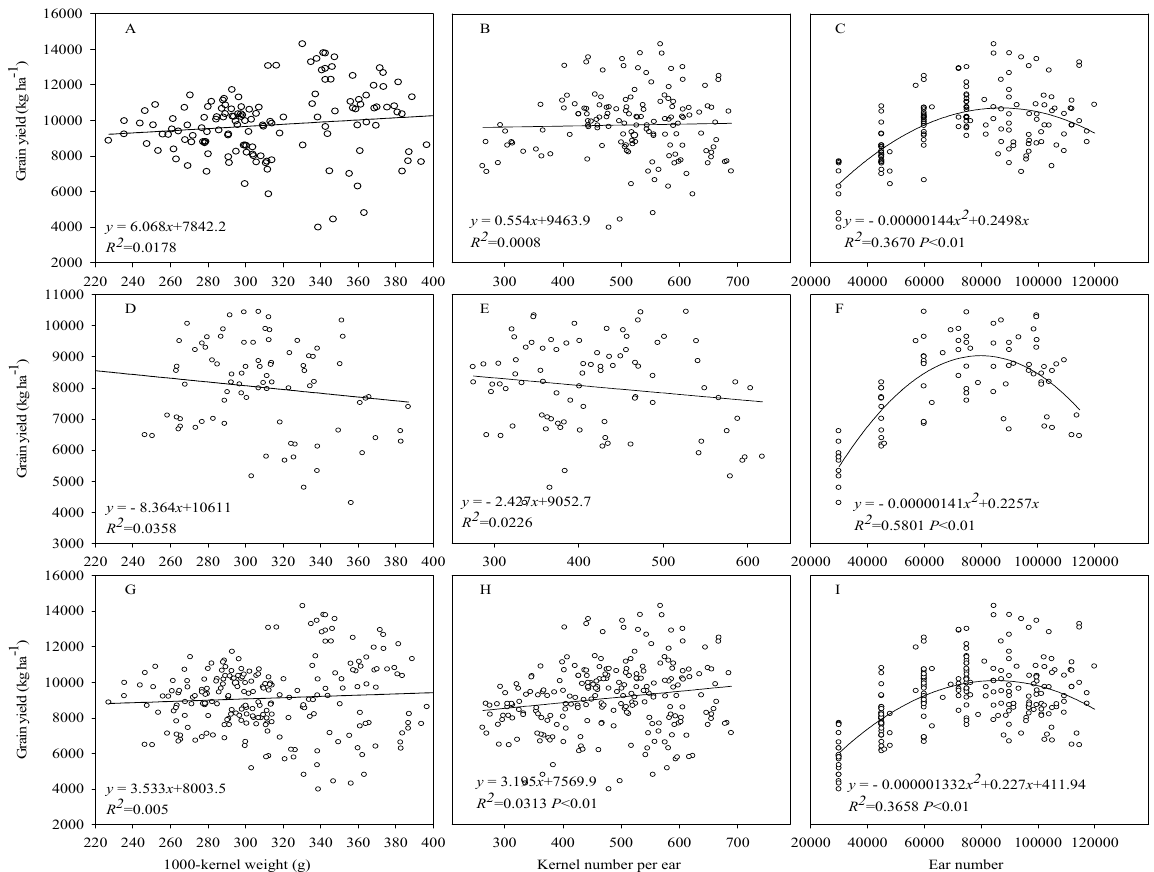
300 252 Figure 2. Relationship between grain yield and its components. 253 Figure 2. Relationship between grain yield and its components. Note: Figure ( A – C ) represent the relationship between grain yield and yield components in Taihe. Figure ( D – F ) represent the rela- tionship between grain yield and yield components in Hefei. Figure ( G – I ) represent the relationship Note: Figure A, B and C represent relationship between grain yield and yield components in Taihe. Fig- 254 between grain yield and yield components in Taihe and Hefei. ure D, E and F represent relationship between grain yield and yield components in Hefei. Figure G, H 255 and I represent relationship between grain yield and yield components in Taihe and Hefei. 256 The quadratic model observed that, between grain yield and planting density (Table 5), with the significant regression equation y = − 1.44 × 10 − 6 x 2 + 0.2498 x ( R 2 = 0.367) in Taihe, the agronomic optimal planting density (AOPD) was 8.6 × 10 4 plants ha − 1 based on the equation, and yield at the AOPD was 10,768.3 kg ha − 1 (Tabel 5). The 95% CI broadened from 7.6~9.7 × 10 4 plants ha − 1 between the lower and upper limit in Taihe. The significant regression equation in Hefei was y = − 1.41 × 10 − 6 x 2 + 0.2257 x ( R 2 = 0.5801). The AOPD